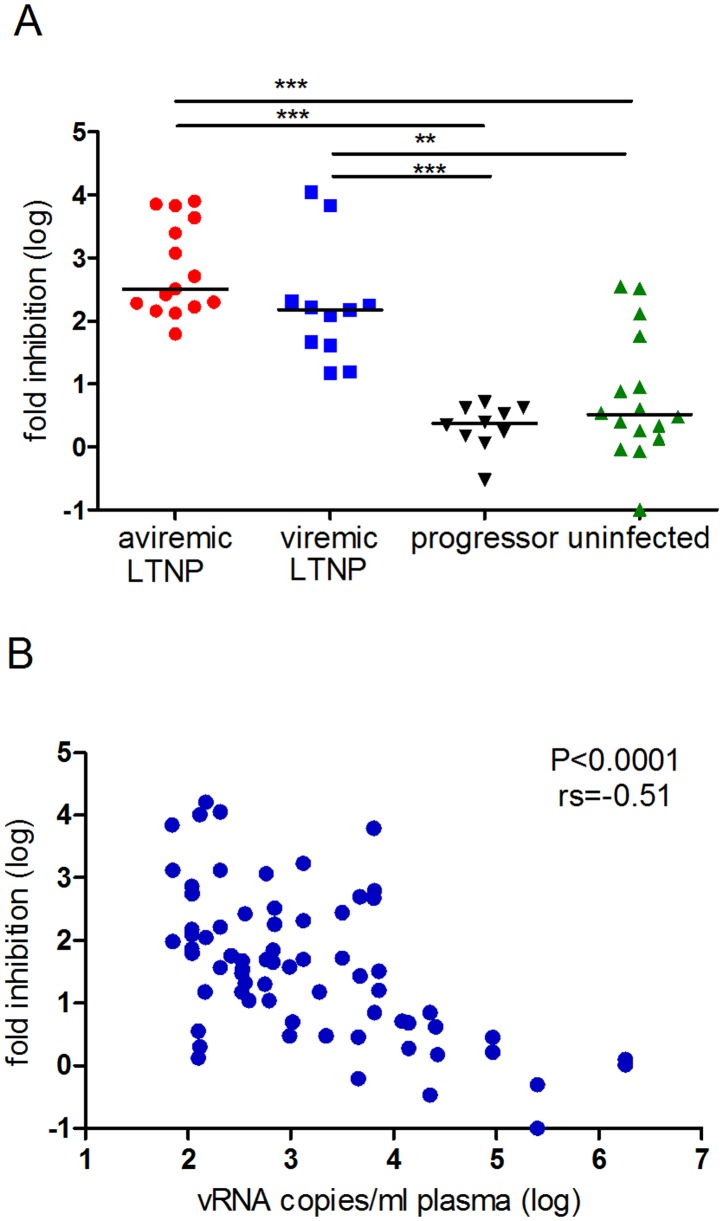
CNAR is strongest in LTNPs and correlates inversely with viral load.(A) CNAR was significantly stronger in SIV-infected LTNPs compared to uninfected macaques and progressors. Viral inhibition was tested with CD8+ cells from 15 aviremic and 11 viremic (geometric mean: 1780 viral RNA copies/ml plasma) long-term non-progressing macaques (LTNPs), 16 uninfected macaques and 10 SIV-infected macaques with progressing disease (geometric mean: 2.41E+04 viral RNA copies/ml plasma). Each dot represents the median of up to 10 viral inhibition tests performed with CD8+ cells from one macaque (mean number of tests per animal: 3.3, STABW = 2.4). Significance (nonparametric Kruskal Wallis test followed by Dunn's test for multiple comparison) is indicated by asterisks (*: p<0.05, **: p<0.01, ***: p<0.001). Median is indicated. (B) CNAR correlated inversely with plasma viral load. Fold viral inhibition (log) was assessed in 70 assays, each performed in triplicate, with CD8+ cells from in total 11 viremic LTNPs and 10 progressors (mean number of assays per animal = 3.3, STABW = 2.8) and correlated significantly with plasma viral load (spearman rank order correlation, p<0.0001, rs = -0.51). Data were taken from S2 and S3 Tables.